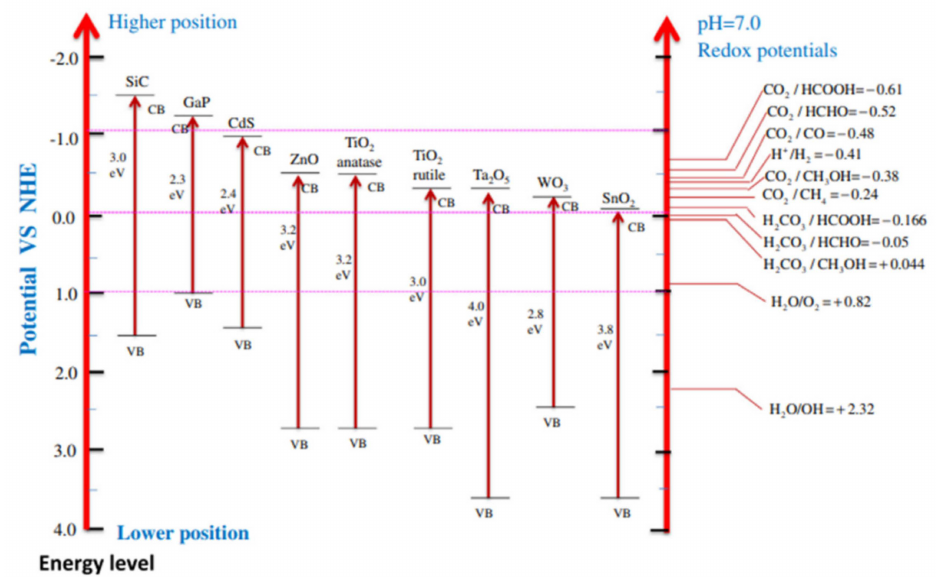
Figure 10. Schematic diagram of CB potentials of semiconductors and thermodynamic reduction potentials of various photocatalyst measured at pH 7. Reprinted with permission from Elsevier, 19 December 2021 Ref.